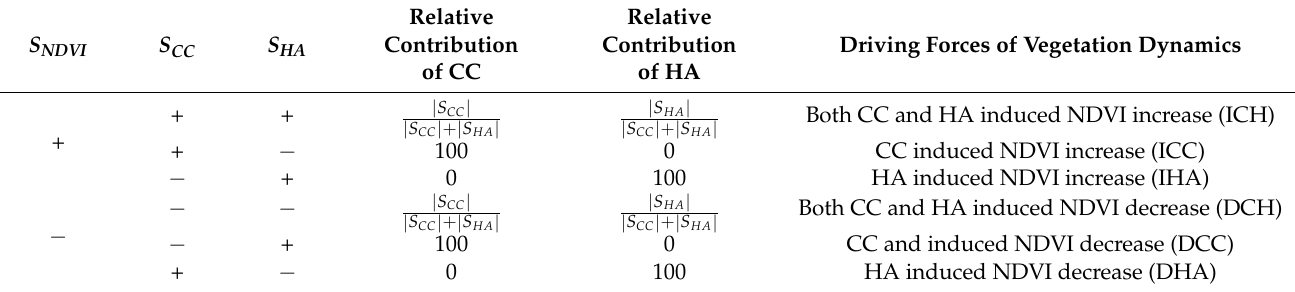
Table 2. Assess the relative contribution of climate change (CC) and human activity (HA) drivers in vegetation dynamics under six scenarios.